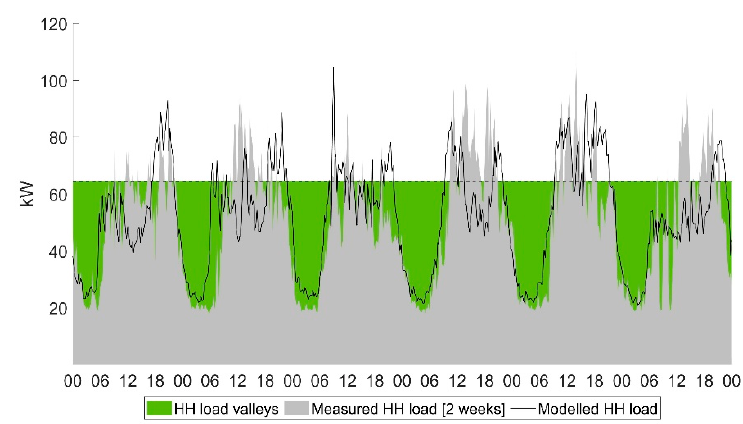
Figure 2. Measured household load in the residential area of the Urcharge project (2 weeks data) and the aligned common yearly household (HH) load profiles with peaks and valleys.